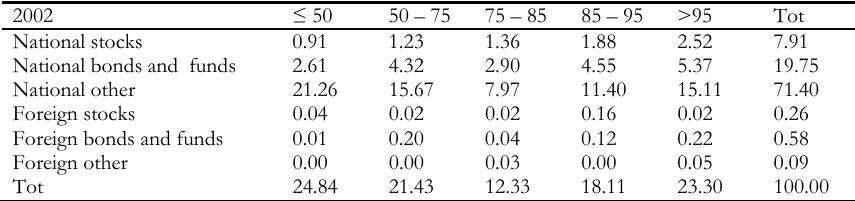
Italian households financial wealth by total real wealth percentiles, 2002 , percentages